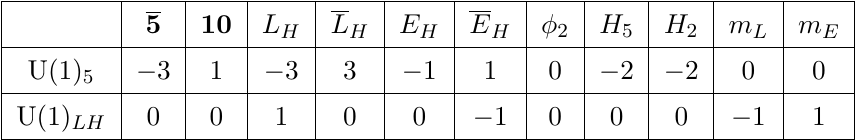
Table 3. The global U(1) 5 and U(1) LH charges of fermions and scalars are shown. Here, U(1) LH charges of m L,E in eq. (3.4) are charges of